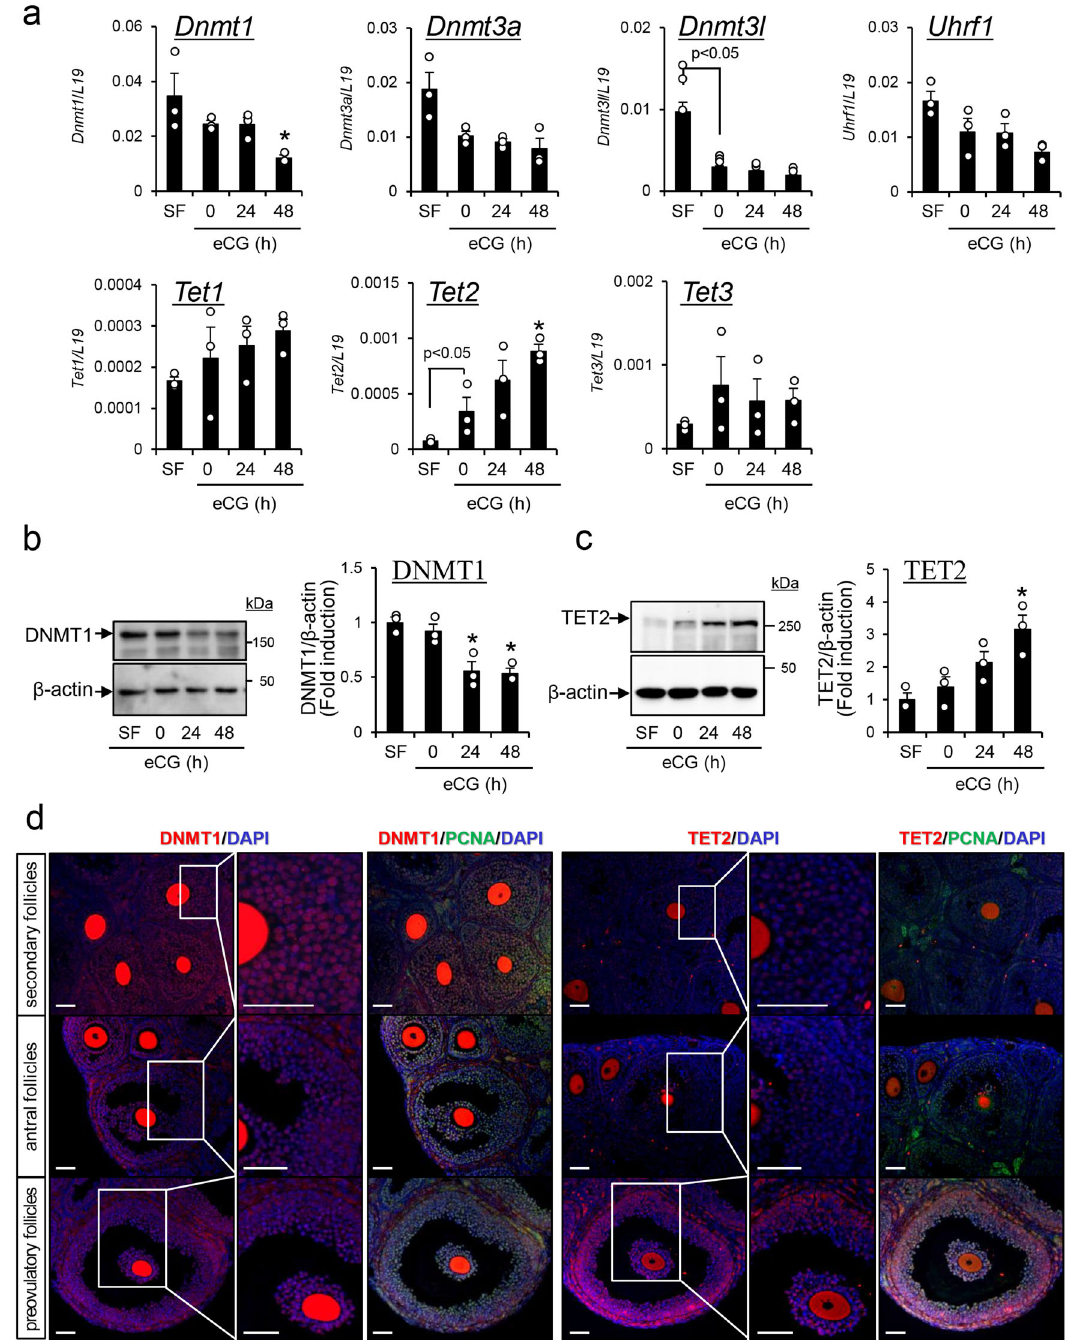
Fig. 1 Kinetic changes in the expression levels of genes involved in epigenetic regulatory mechanisms in mouse granulosa cells during follicular development. a The expression levels of epigenetic-related genes in granulosa cells. Levels of mRNA were normalized to that of L19 . Data represents the mean ± SEM ( n = 3 biological replicates). Signi fi cant differences were observed between SF and eCG at 0 h ( p < 0.05). *Signi fi cant differences were induced by eCG injection compared with before eCG injection (0 h) ( p < 0.05). SF, secondary follicles. b , c Temporal changes of DNMT1 ( b ) and TET2 ( c ) in granulosa cells of secondary follicles (SF) with multilayered granulosa cells and antral follicles before or after eCG stimulation. β -Actin was used as a loading control. The results are representative of three independent experiments. Immunoblots shown are representative of three independent experiments. In each experiment, the different protein samples were used ( n = 3 biological replicates). Quantitative expression of DNMT1 and TET2 relative to the expression of β -actin (control), as determined by western blotting. The SF value was set as 1 and the data are expressed as fold induction. The values are the mean ± SEM ( n = 3 biological replicates). Signi fi cant differences were observed between SF and eCG at 0 h ( p < 0.05). *Signi fi cant differences were induced by eCG injection compared with before eCG injection (0 h) ( p < 0.05). Full-length blotting images of DNMT1, TET2, and β -actin are shown in Supplementary Fig. 8. d The localization of DNMT1, TET2, and PCNA in secondary follicles (SFs) and antral follicles (AFs) of 3-week-old immature mice or preovulatory follicles (PFs) of ovaries collected 48 h after eCG injection. DNMT1 and TET2 were visualized with Cy3, PCNA was visualized with FITC, and nuclei were stained with DAPI in the ovaries of 3-week-old mice treated with or without eCG. All of different length scale bars show 50 μ m.